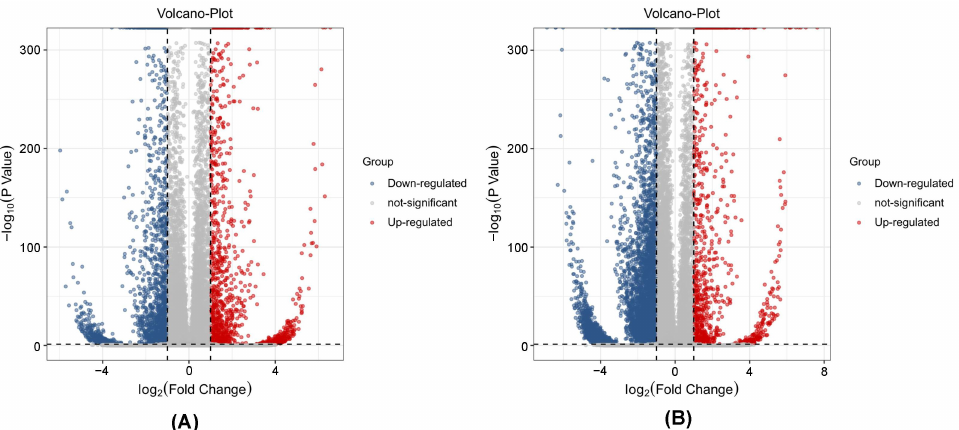
Figure 7. Volcano plot of differentially expressed genes in ginseng leaves ( A ) and ginseng stems ( B ). Up- and down-regulated genes are reported as blue and red dots, respectively. Not DEGs are represented as gray dots. p threshold (=0.05) is reported in a dotted line. DEGs: differential expression genes.